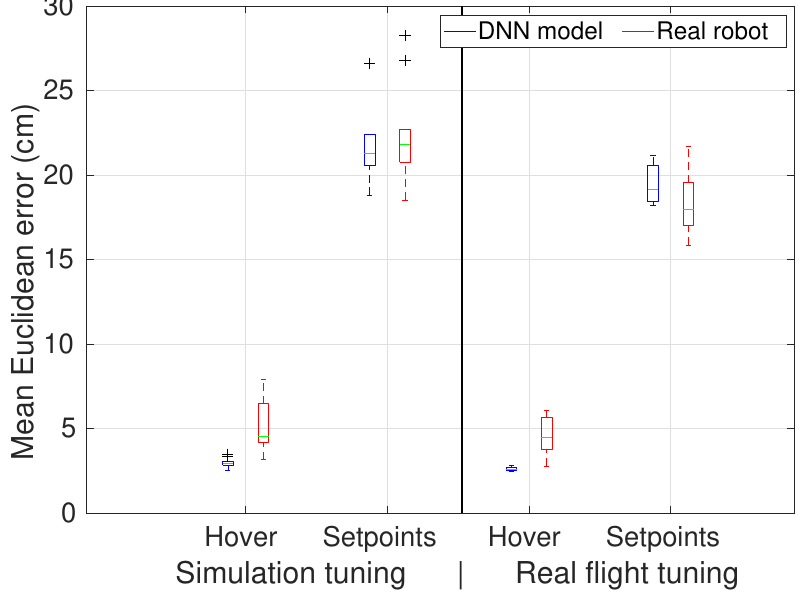
Figure 5. Boxplot of mean Euclidean error obtained by the weight sets having top ten grade values in the lookup tables from simulation ( left ) and real flight ( right )